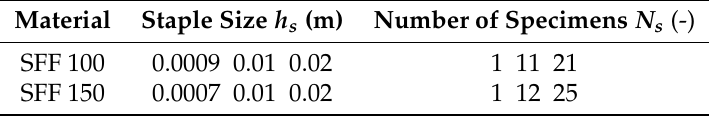
Table 3. Staple sizes of punched specimens of SFF 100 and SFF